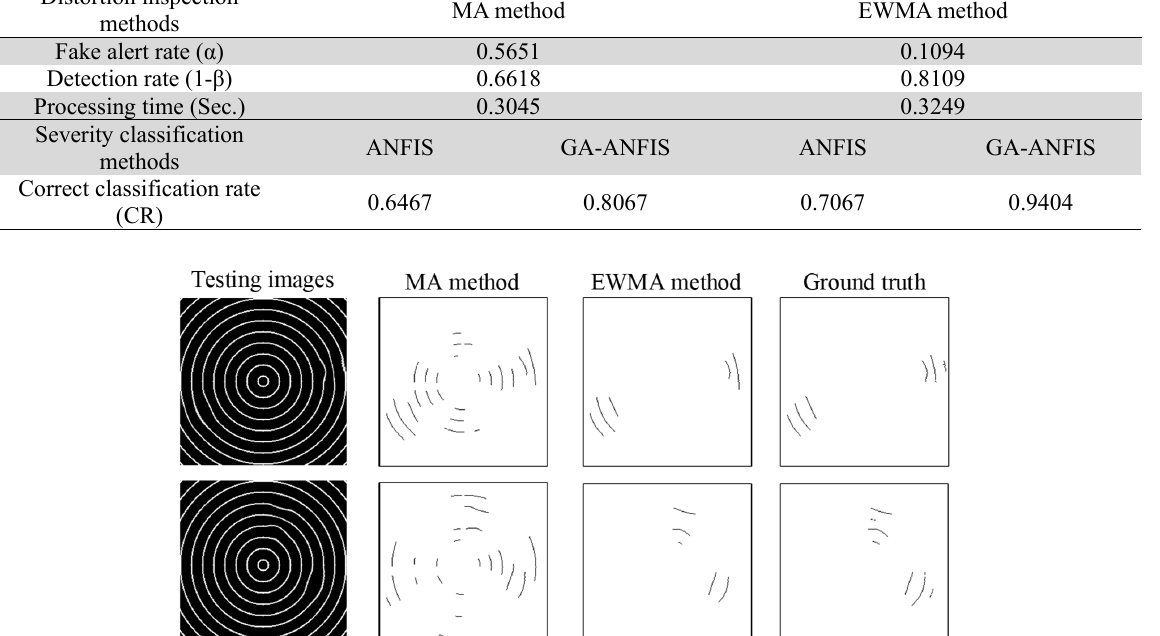
Fig. 9. Partial results of imaging distortion inspection by the proposed method using two distinct small variation control